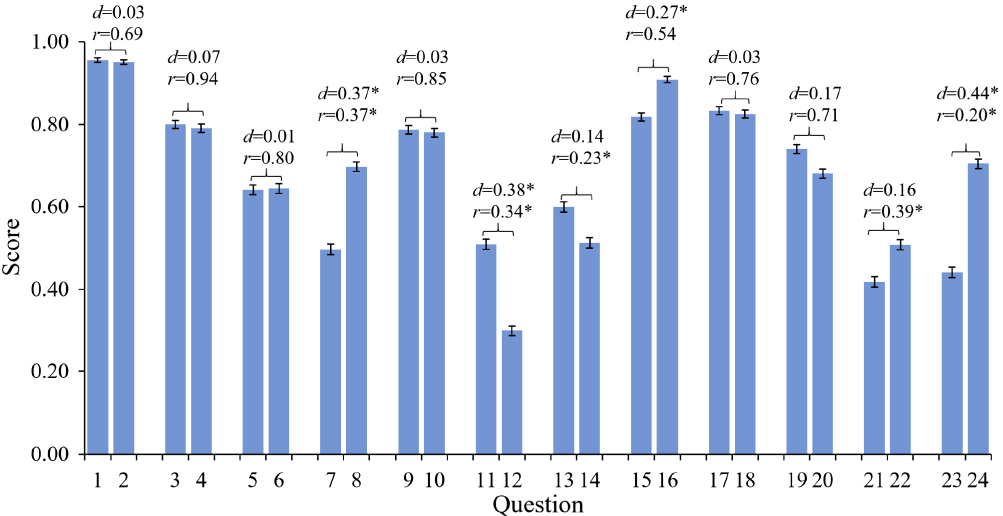
FIG. 2. The average scores of individual questions and the correlation r and Cohen ’ s d between the two individual question scores in each question pair. The values of Cohen ’ s d larger than 0.2 and the values of r less than 0.4 are marked with an * [70].